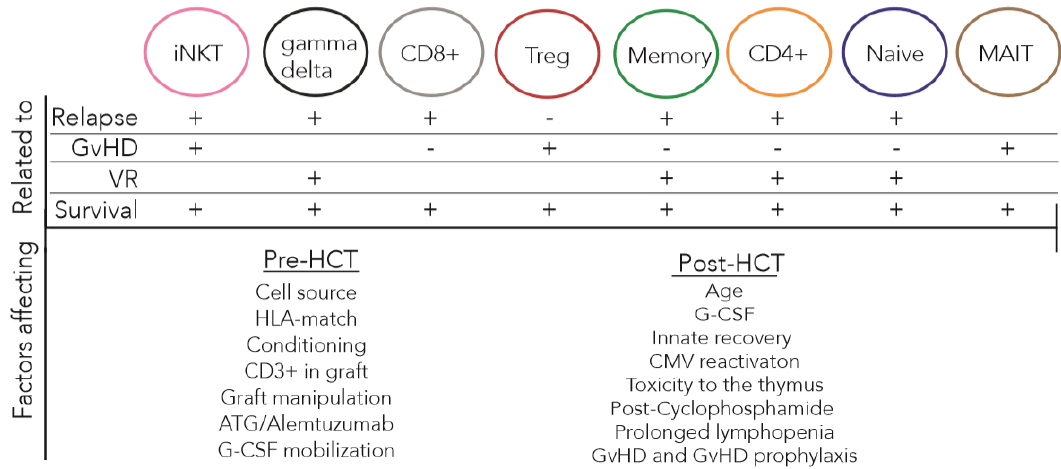
Figure 2. Overview of T cell subset related to allogeneic HCT outcomes and factors a ff ecting T cell reconstitution before and after allo-HCT. Adequate reconstitution of the distinct T cell subsets is di ff erently correlated to relapse, GvHD, VR and overall survival following allo-HCT. Adequate reconstitution of the T cell compartment is highly influenced by distinct factors before and after